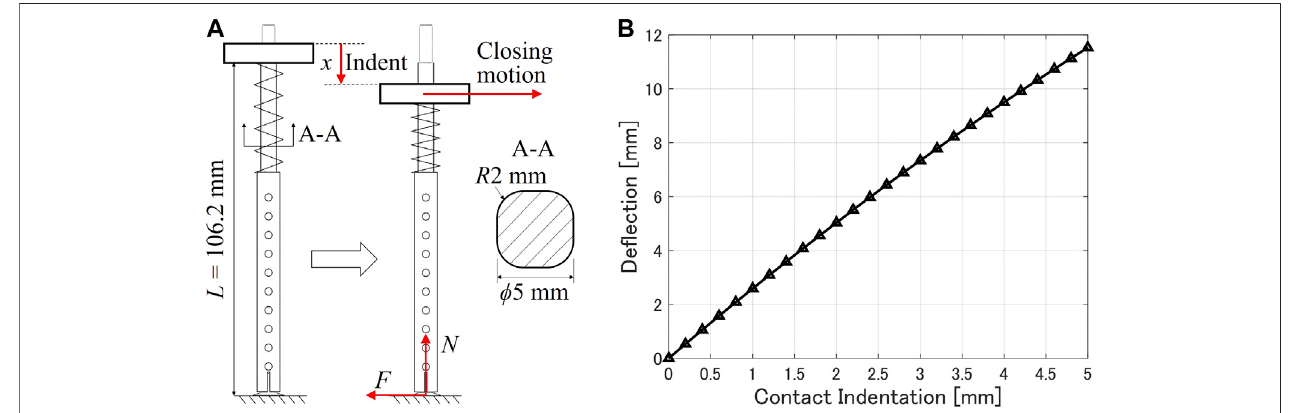
FIGURE 3 | (A) Beam model of the scoop-binding mechanism to calculate the bending de fl ection. (B) Calculated bending de fl ection as a function of the contact indentation.